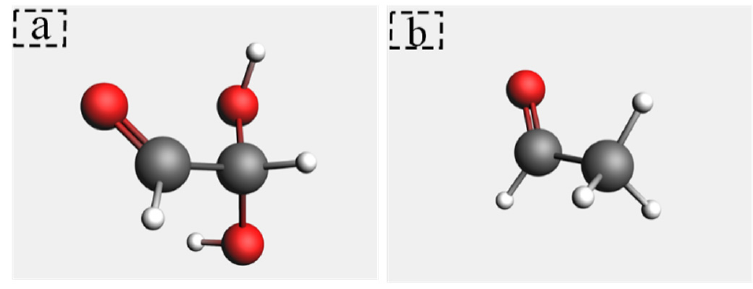
Figure 4. Molecular model. ( a ) is acetaldehyde; ( b ) is 2,2 ‐ dihydroxyacetaldehyde.